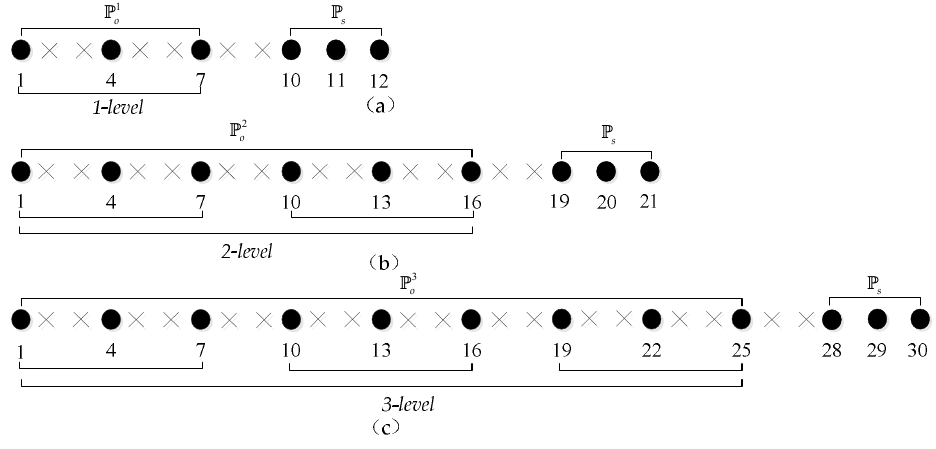
3 N N   : ( a ) k = 1; ( b ) k = 2; ( c ) k = 3. Figure 2. An example of k -level extended array with N 1 = N 2 = 3: ( a ) k = 1; ( b ) k = 2; ( c ) k = 3. 1 2